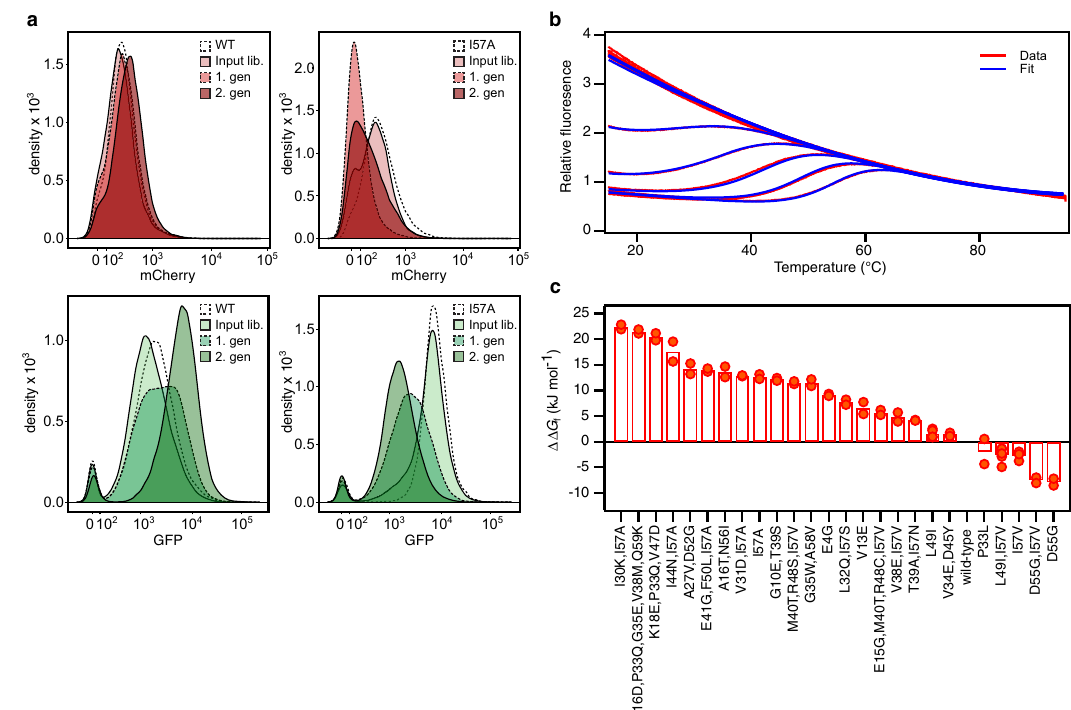
Fig. 1 Selection and stability of CI2 variants. a FACS pro fi les of E. coli cultures expressing libraries of random mutations in wild-type CI2 (left column) and in CI2,I57A (right column). mCherry fl uorescence and GPF fl uorescence are shown in the upper and lower rows, respectively. Pro fi les for the background variants of CI2, the input mutant library and the two rounds of sorting are shown. b Thermal unfolding curves of CI2,I57A measured by fl uorescence at 350 nm at 13 concentrations of GuHCl ranging from 0 to 5 M. The experimental data are shown in red and the fi ts to a model for two-state folding as blue lines. c Difference in the free energy for folding, ΔΔ G f , relative to wild-type CI2 for 26 variants. The Δ G f for each variant was found by non-linear global fi ts of fl uorescence unfolding data. For most variants two denaturant series were fi tted ( n = 2), except for L49I ( n = 4), I57V ( n = 3) and L49I/I57V ( n =